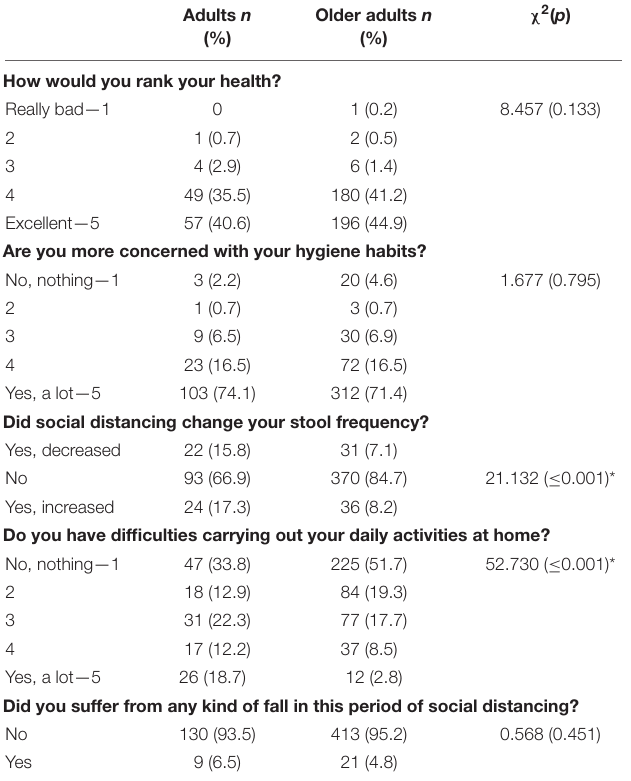
TABLE 3 | Perception of health and physical state of adults ( n = 139) and older adults ( n = 437) during social distancing due to the COVID-19 pandemic. χ 2 ( p ) Adults n Older adults n (%) (%)